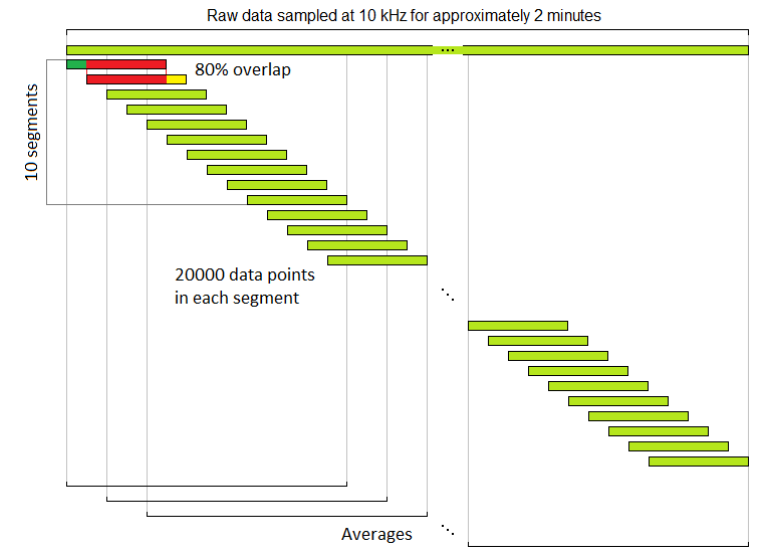
Table 2. The number of raw data points and averages in each case.